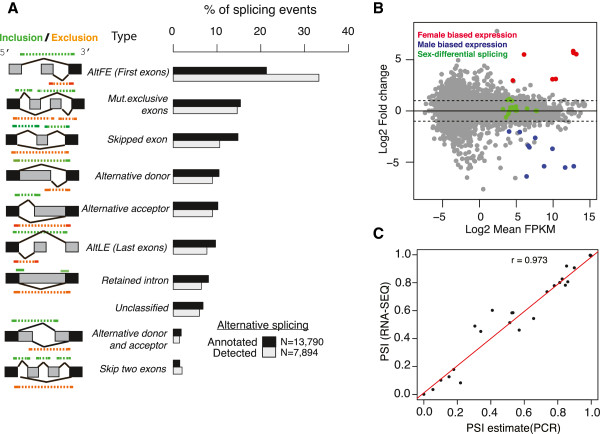
Splicing event characterization in Drosophila heads. (A) Pairwise splicing events defined for all transcript models in Flybase 5.39 annotation (black bars), and the subset of those detected as alternatively spliced in female and male Drosophila heads by Spanki (grey bars). Black bars indicate splicing event classes as a percent of all defined pairwise events. Grey bars indicate splicing events detected as a percent of all detected events. Cartoons of each event type are in the leftmost column, with the “inclusion” form indicated in green, and the “exclusion” form indicated in orange. A description of each type is adjacent to each cartoon. The “Unclassified” types includes diverse complex type with no concise verbal description. (B) Ratio vs average abundance scatterplots of gene expression in female and male heads. Genes with significant sex-biased gene-level expression (FDR adjusted p < 0.05, Cuffdiff) in females (red), or males (blue). Remaining detected expression events are in grey. Transcripts showing sex-biased splicing have been projected onto the gene-level expression data (green). (C) Scatter plot of percent spliced in (PSI) by RNA-Seq vs qPCR for the inclusion or exclusion form for each event assayed (the PCR primer pairs differ for detecting exon inclusion or exclusion but approximates PSI). Inset is Pearson’s r coefficient.